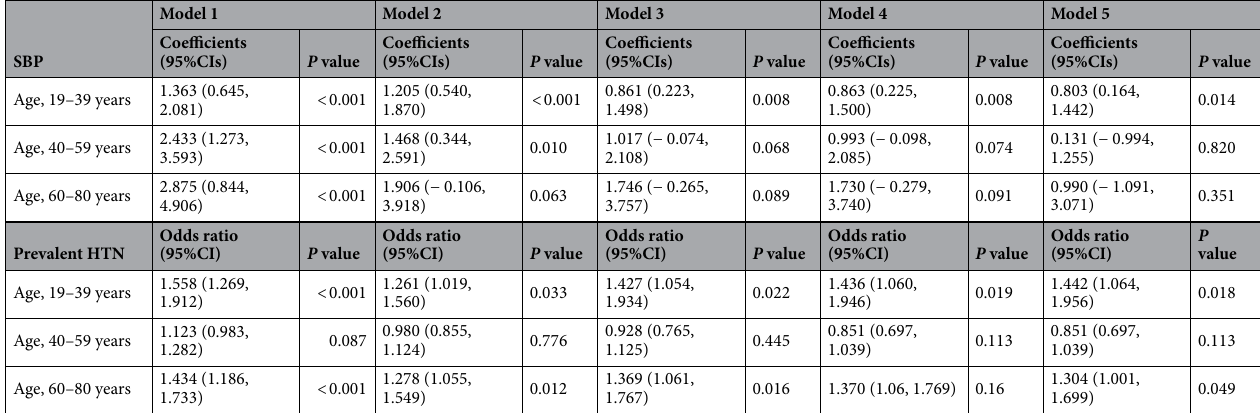
Table 4. Impact of low parental educational status on SBP and prevalent HTN in the subgroups stratified by age. Model 1, unadjusted. Model 2, adjusted for age and sex. Model 3, model 2 + adjusted for co− morbidities (high body mass index, high waist circumference, diabetes, dyslipidemia, coronary artery disease, stroke, and history of smoking). Model 4, model 3 + adjusted for eGFR and proteinuria). Model 5, model 4 + adjusted for educational status of individual subjects. CI, confidence interval; HTN, hypertension; SBP, systolic blood